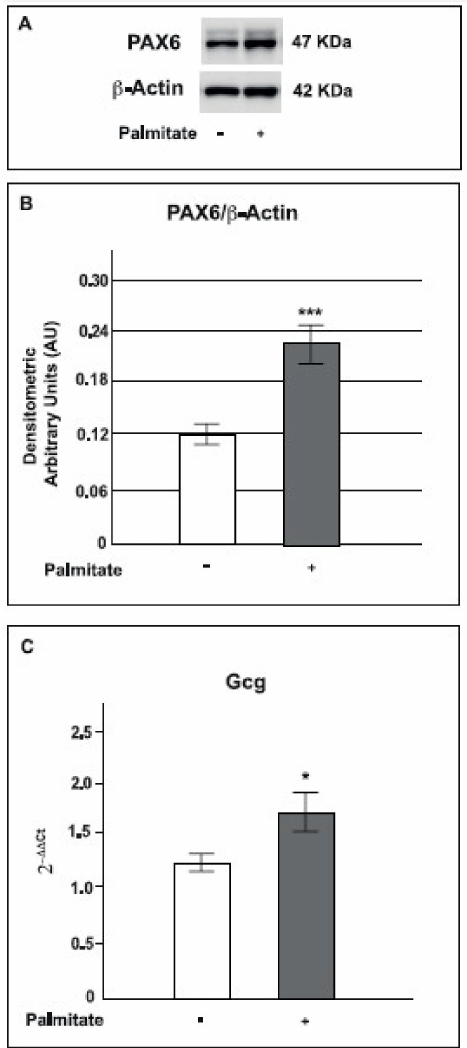
Figure 6. Effect of palmitate on PAX6 and proglucagon expression in GLUTag cells. A : representative Western blot for PAX6 and β -actin from control and palmitate GLUTag treated cells (0.5 mM for 24 h). B : corresponding densitometric analysis in control cells (open bars) and in cells exposed to palmitate (gray bars). *** p < 0.001 vs. control (1-way ANOVA followed by Bonferroni test, n = 3). C : box plot of proglucagon ( GcG ) mRNA expression in control and palmitate treated cells (0.5 mM for 24 h). Values on the y-axis are reported as 2 − ∆∆ C t . Statistical significance was evaluated by t -test ( n = 3, * p < 0.05 compared to control); (+) means presence, (-) means